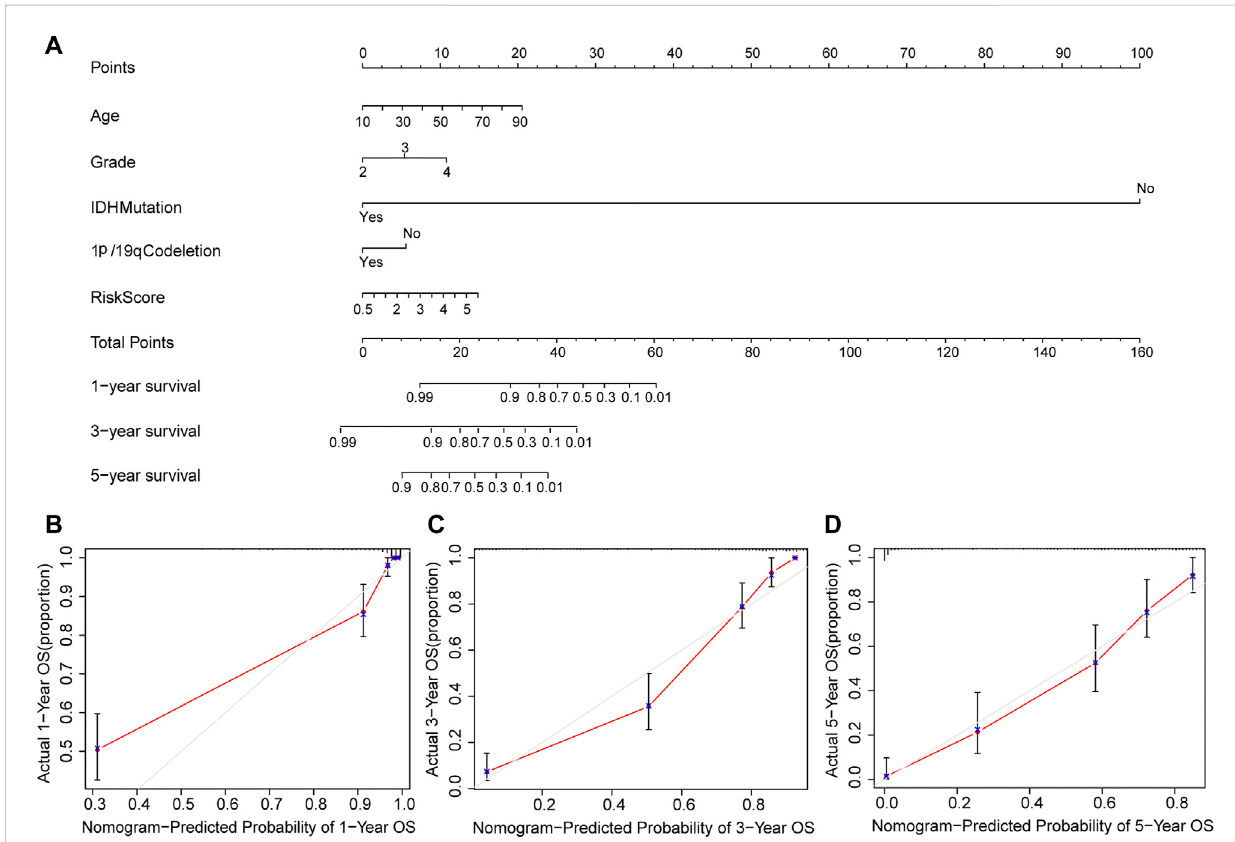
FIGURE 7 Construction of a nomogram. (A) Validation of the nomogram in the TCGA cohort. (B) Calibration plot used to predict the 1-year survival. (C) Calibration plot used to predict the 3-year survival. (D) Calibration plot used to predict the 5-year